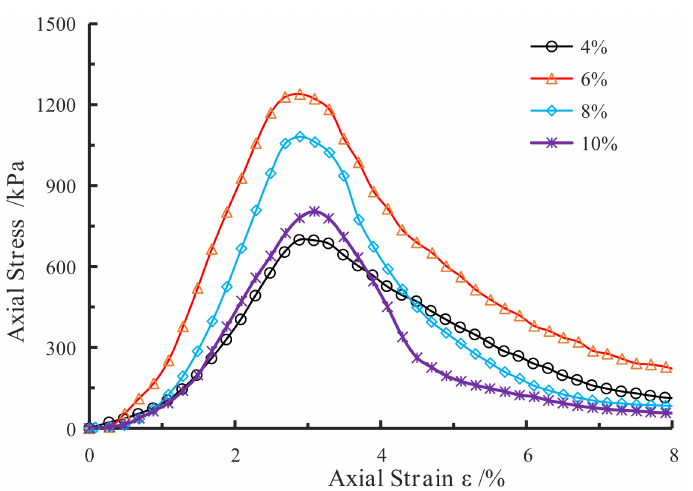
Figure 4. The unconfined compressive stress-strain curves of LS with different lime content.